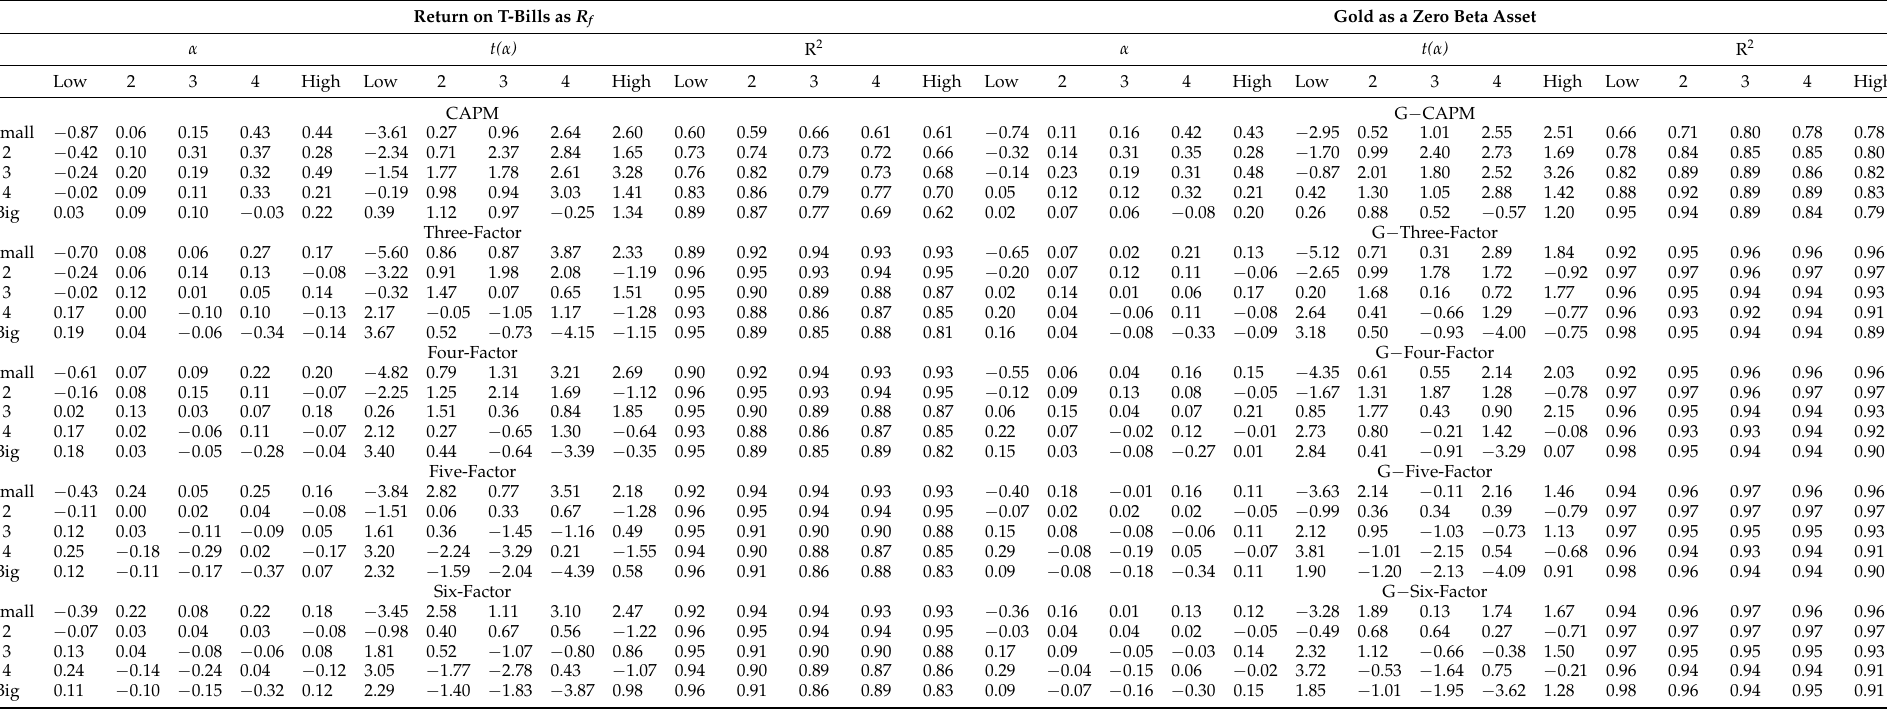
Table 8. Alphas from the CAPM, G-CAPM, three-factor, G-three-factor, four-factor, G-four-factor, five-factor, G-five-factor, six-factor, and G-six-factor regressions on 25 size and book-to-market portfolios from January 1981 to December 2015. The table reports alphas ( α ), t-statistics t( α ) , and adjusted R-squared of the tested